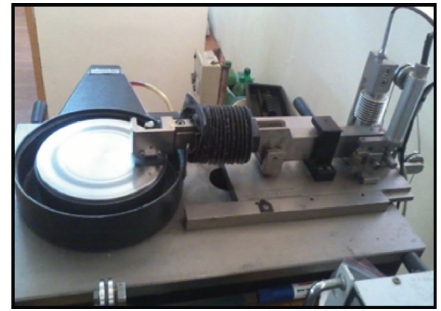
Figure 5: Dry sliding wear test apparatus.